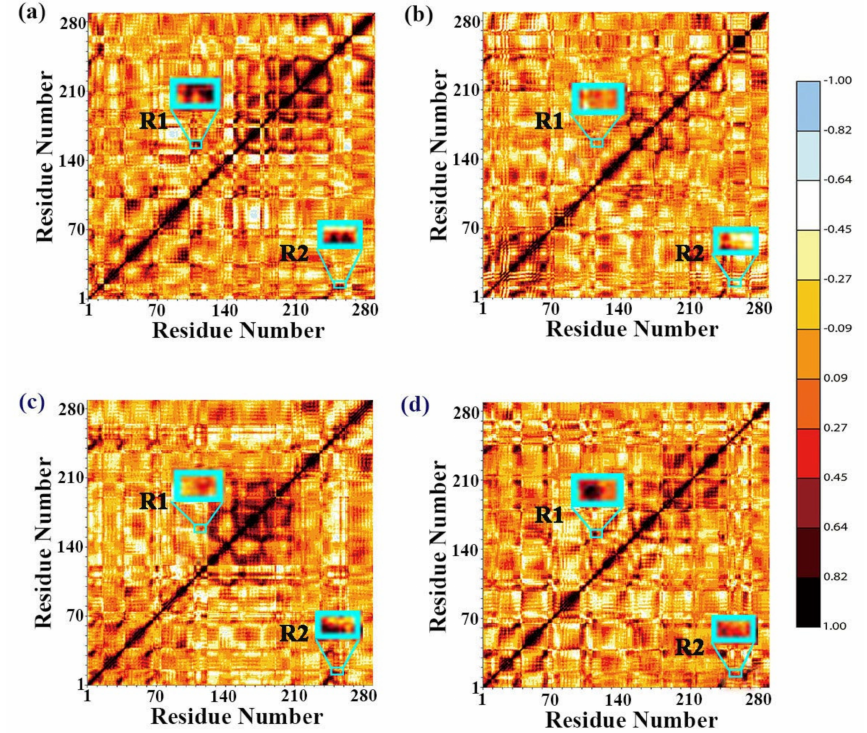
Figure 11. Cross-correlation matrices between residues calculated for four systems: ( a ) DPEase + FUD (50 ◦ C); ( b ) DPEase + FUD (60 ◦ C); ( c ) DPEase + FUD + GO (50 ◦ C); ( d ) DPEase + FUD + GO (60 ◦ C). The regions R1 and R2 marked with cyan color rectangles represent obvious variation in motion